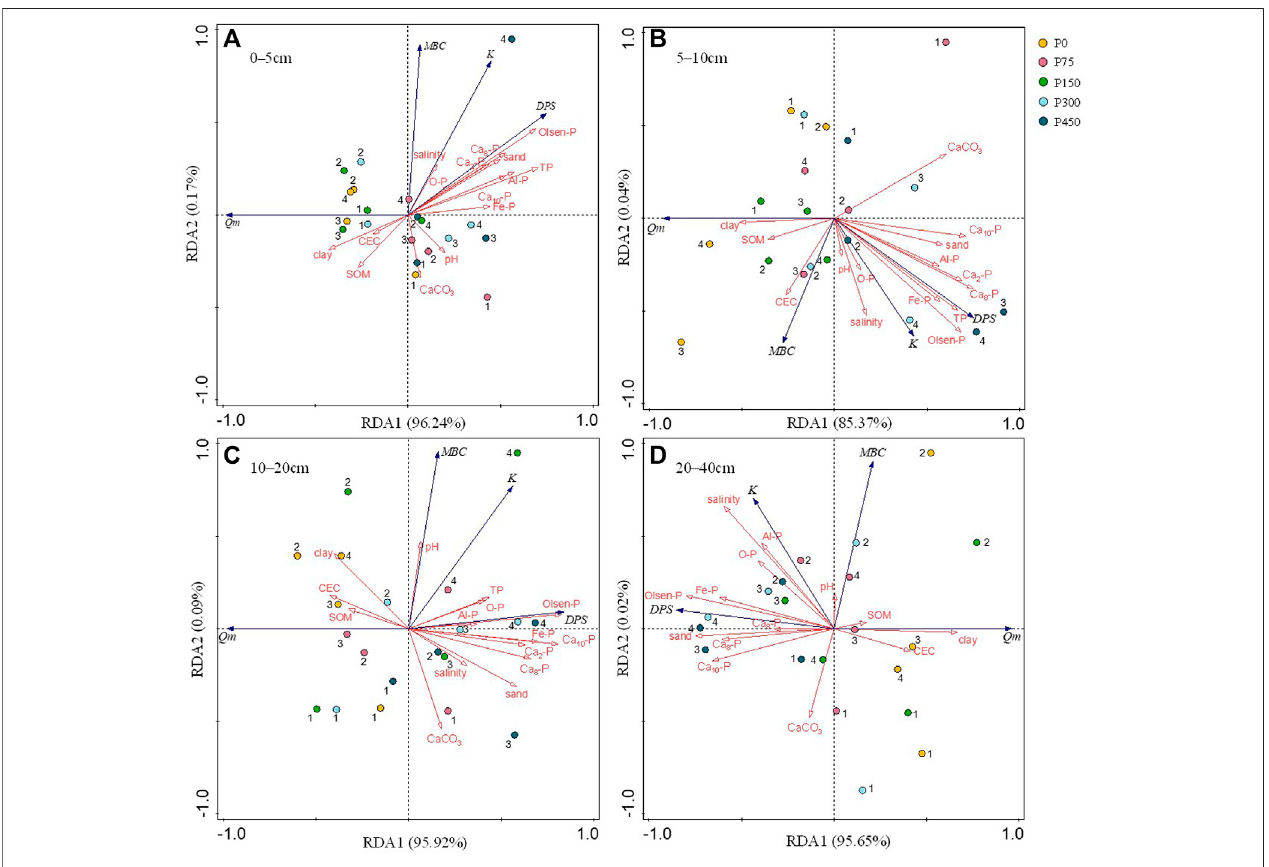
FIGURE 6 | Redundancy analysis showing the correlations between the adsorption – desorption parameters and soil physicochemical properties of different treatments under 4-year fertilization. (A) 0 – 5 cm, (B) 5 – 10 cm, (C) 10 – 20 cm, and (D) 20 – 40 cm. 1, 2, 3, and 4 indicate 2016, 2017, 2018, and 2019, respectively.